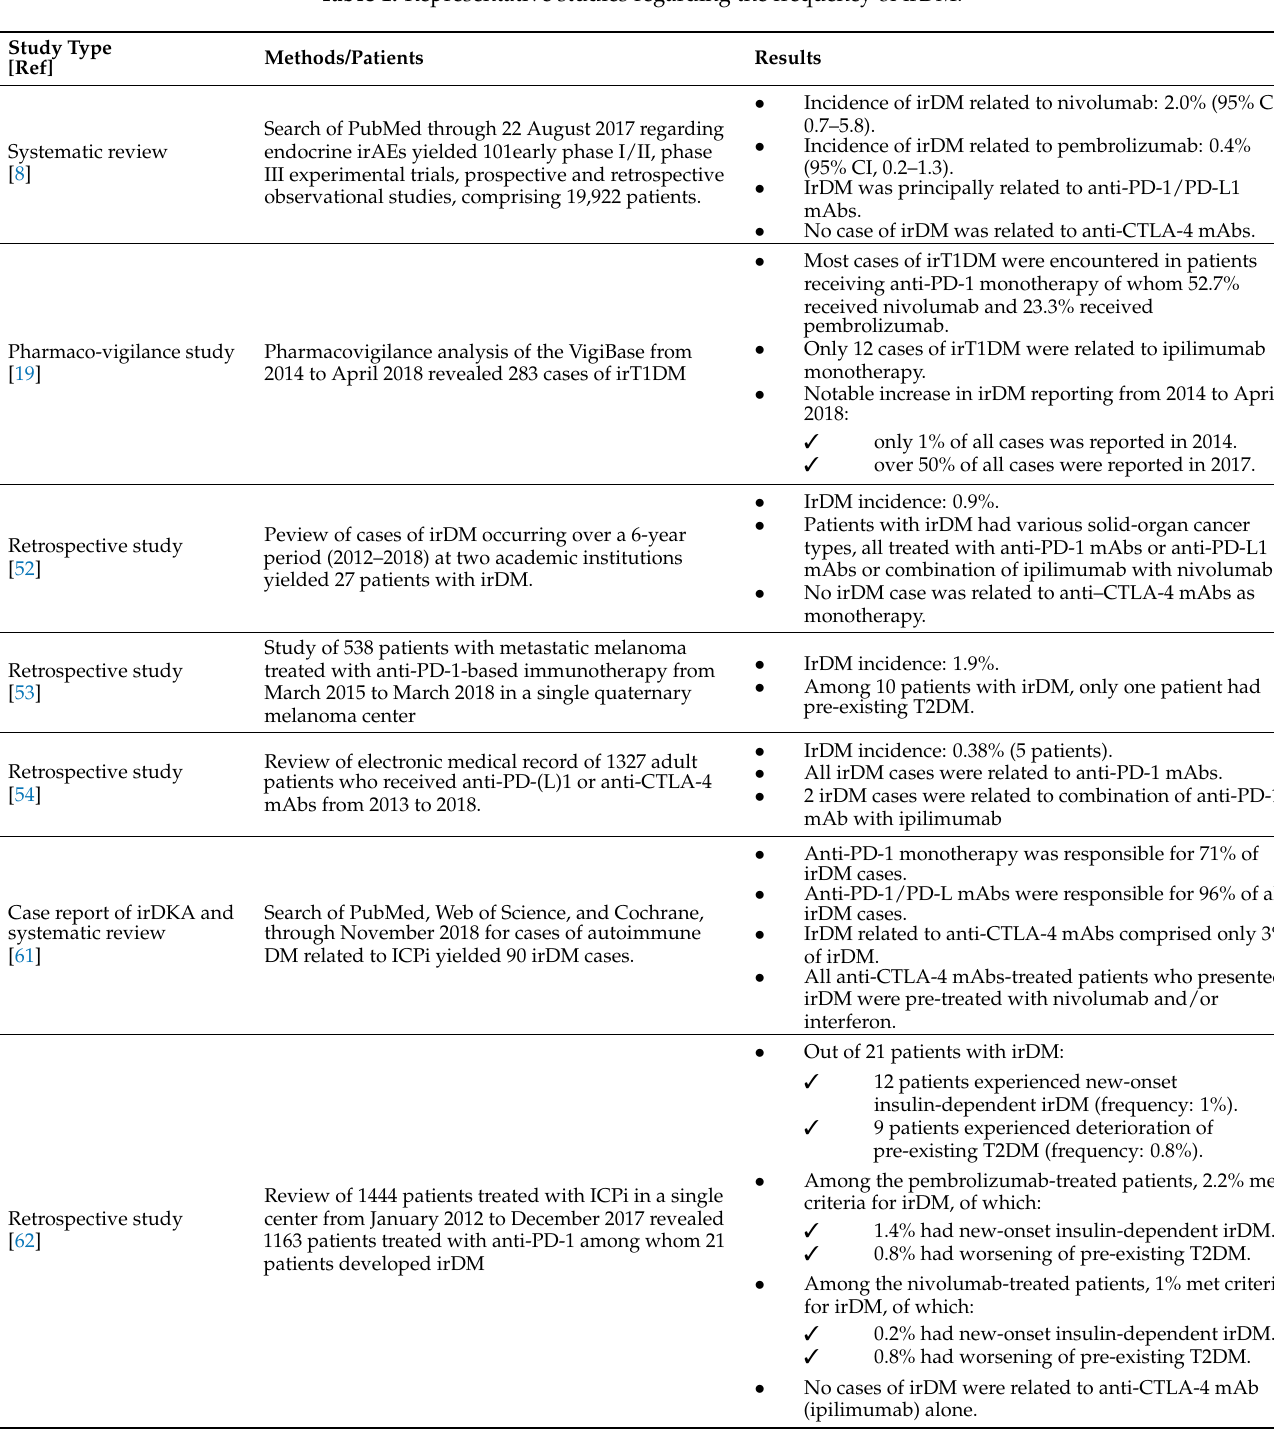
Table 1. Representative studies regarding the frequency of